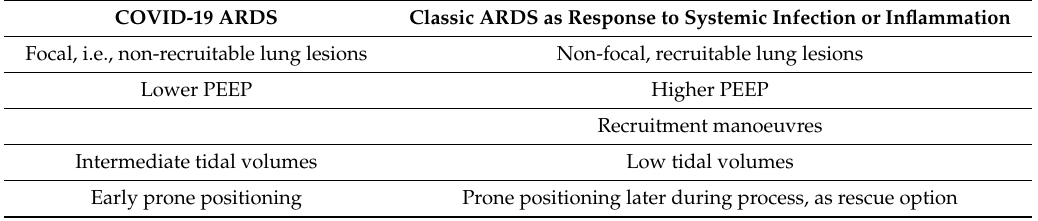
Table 1. Comparison of ARDS features in Covid-19 patients and non-Covid-19